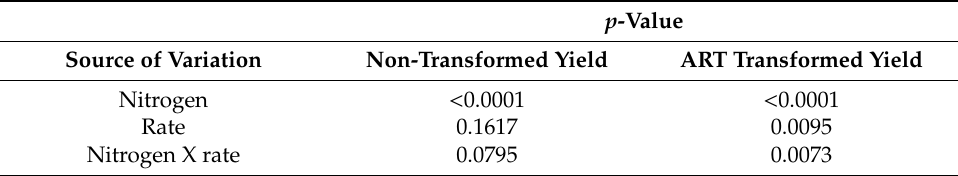
Table 2. p -values for ANOVA of non-transformed and transformed yield data of example 3.